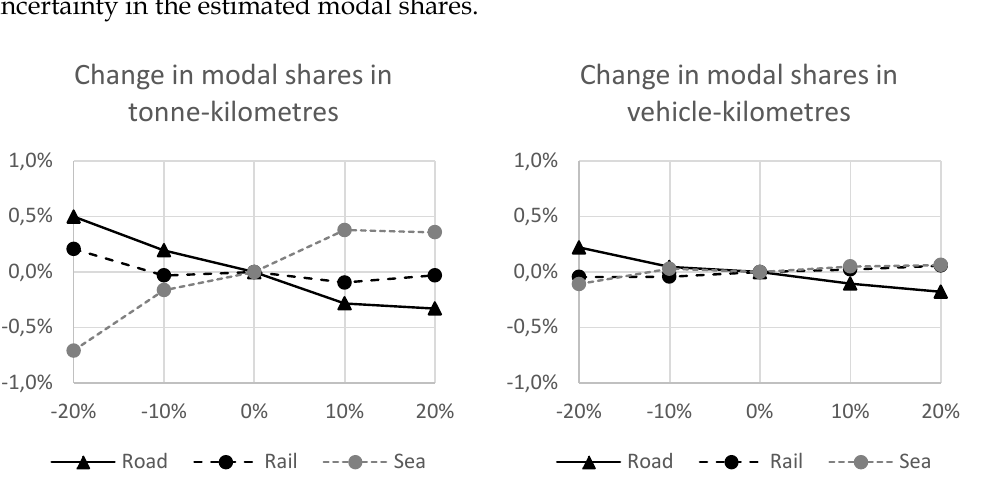
Figure 4. Change in modal shares in tonne-kilometres and vehicle-kilometres per mode inside and outside Sweden as a function of change in total transport volume